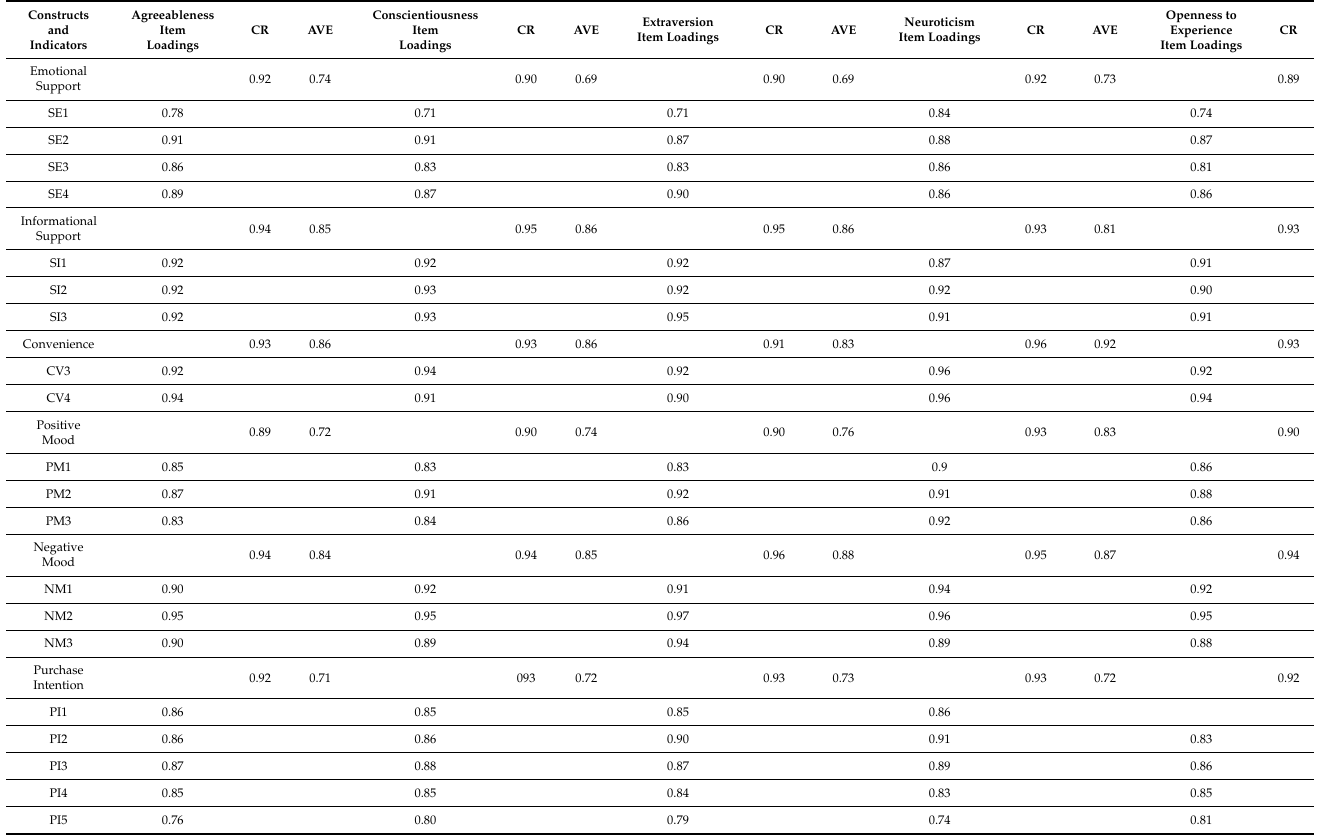
Table A1. Construct reliability and convergent